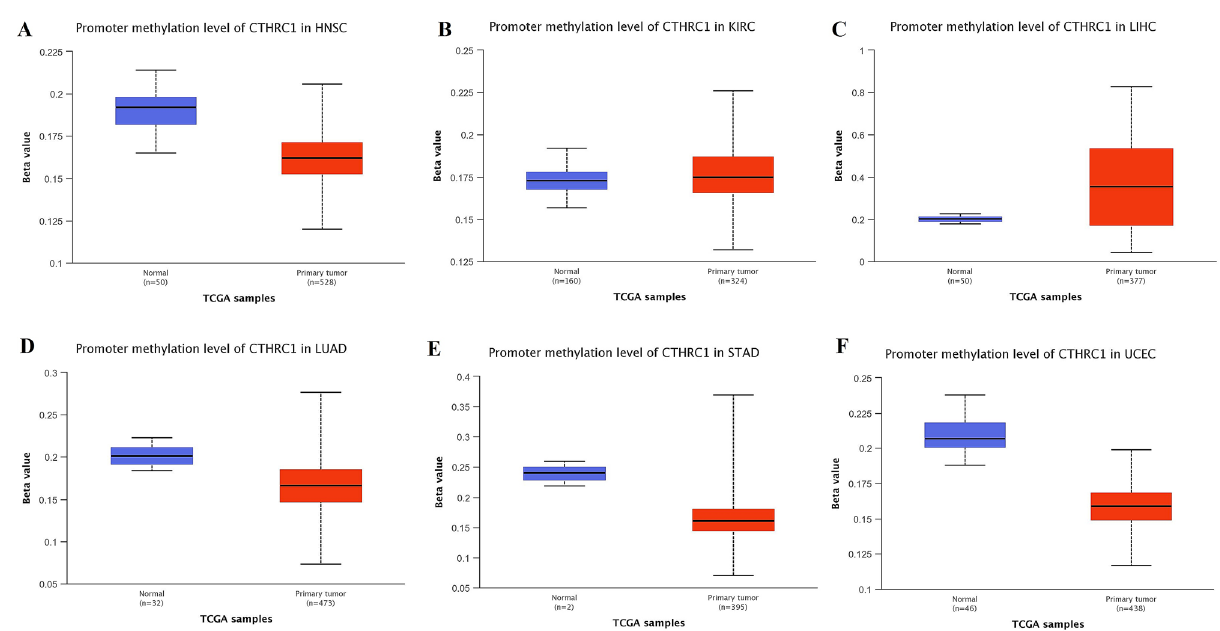
Figure 12. Promoter methylation level of CTHEC1 in HNSC, KIRC, LIHC, LUAD, STAD, and UCEC. ( A ) HNSC, ( B ) KIRC, ( C ) LIHC, ( D ) LUAD, ( E ) STAD, and, ( F ) UCEC. A p-value of < 0.05 was selected as a cutoff